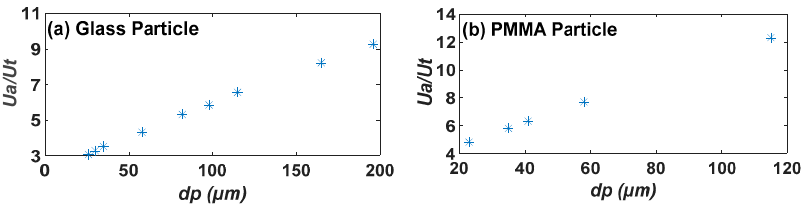
Figure 14. Transition velocity from circulating fluidised bed to transport regime for ( a ) glass and ( b ) PMMA particles with solid inventory in the range of 10–25%.